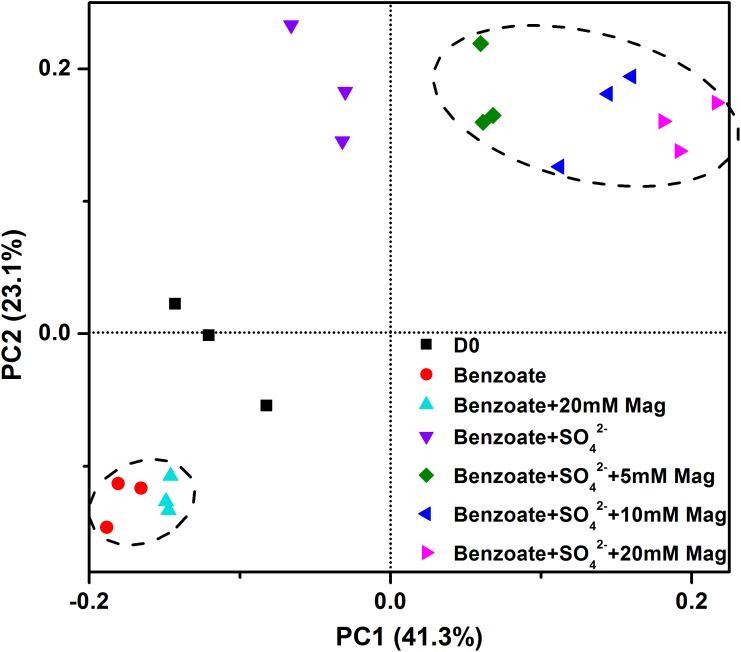
Principal coordinates analysis (PCoA) of microbial communities from sediments incubations of sulfate-dependent benzoate degradation in the presence and absence of magnetite, the sulfate-free control incubations and microbial inocula based on the weighed unifrac distance. Mag denotes magnetite.